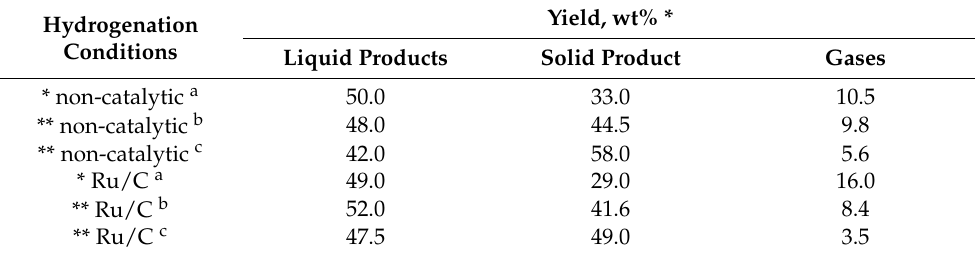
Table 2. The yields of products of hydrogenation in ethanol at 225 ◦ C: initial wood ( a ), alkali-treated wood ( b ), acid-treated wood ( c